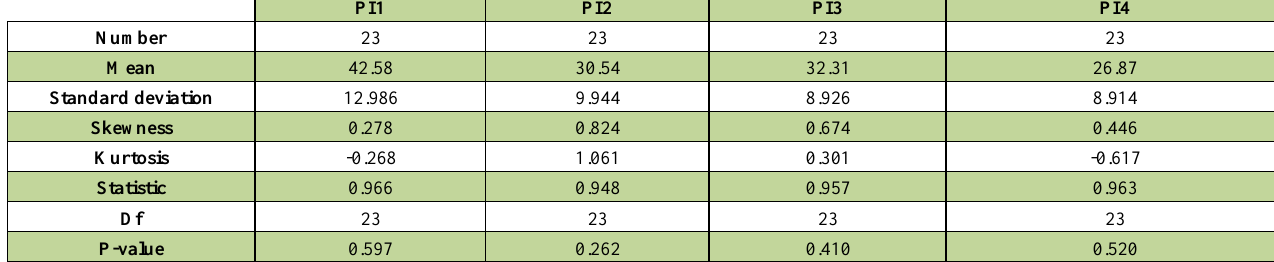
Table 2. Determining the Normal Distribution of Study Data in Group